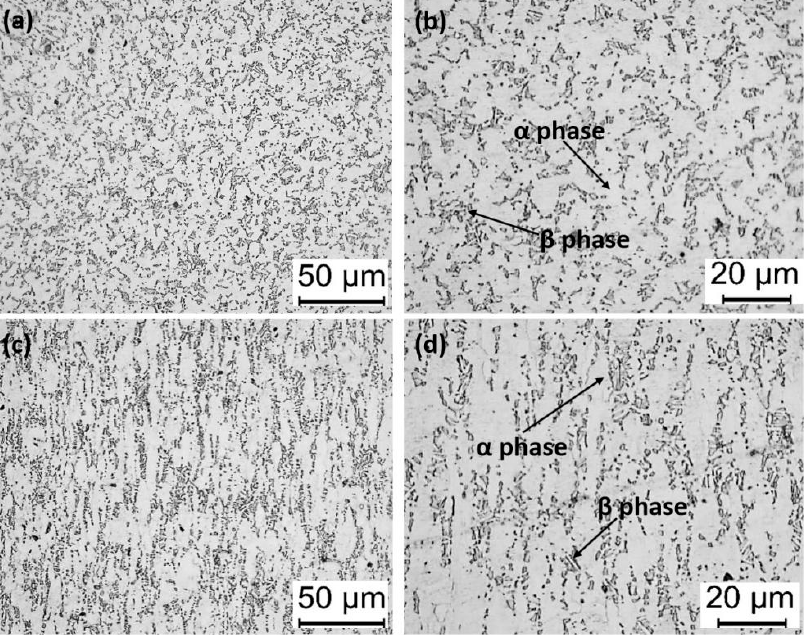
Figure 2. Microstructure of as-received Ti6Al4V alloy ( a , b ) viewed from the radial direction and ( c , d ) viewed from the axial direction. Table 2. Heat treatment scheme of various specimens. Specimen No.